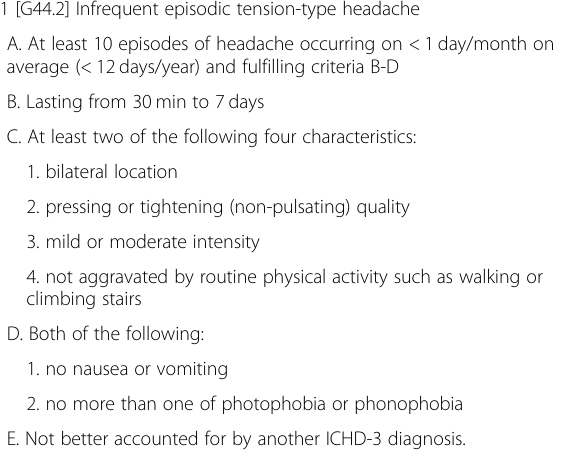
Table 10 Classification of tension-type headache